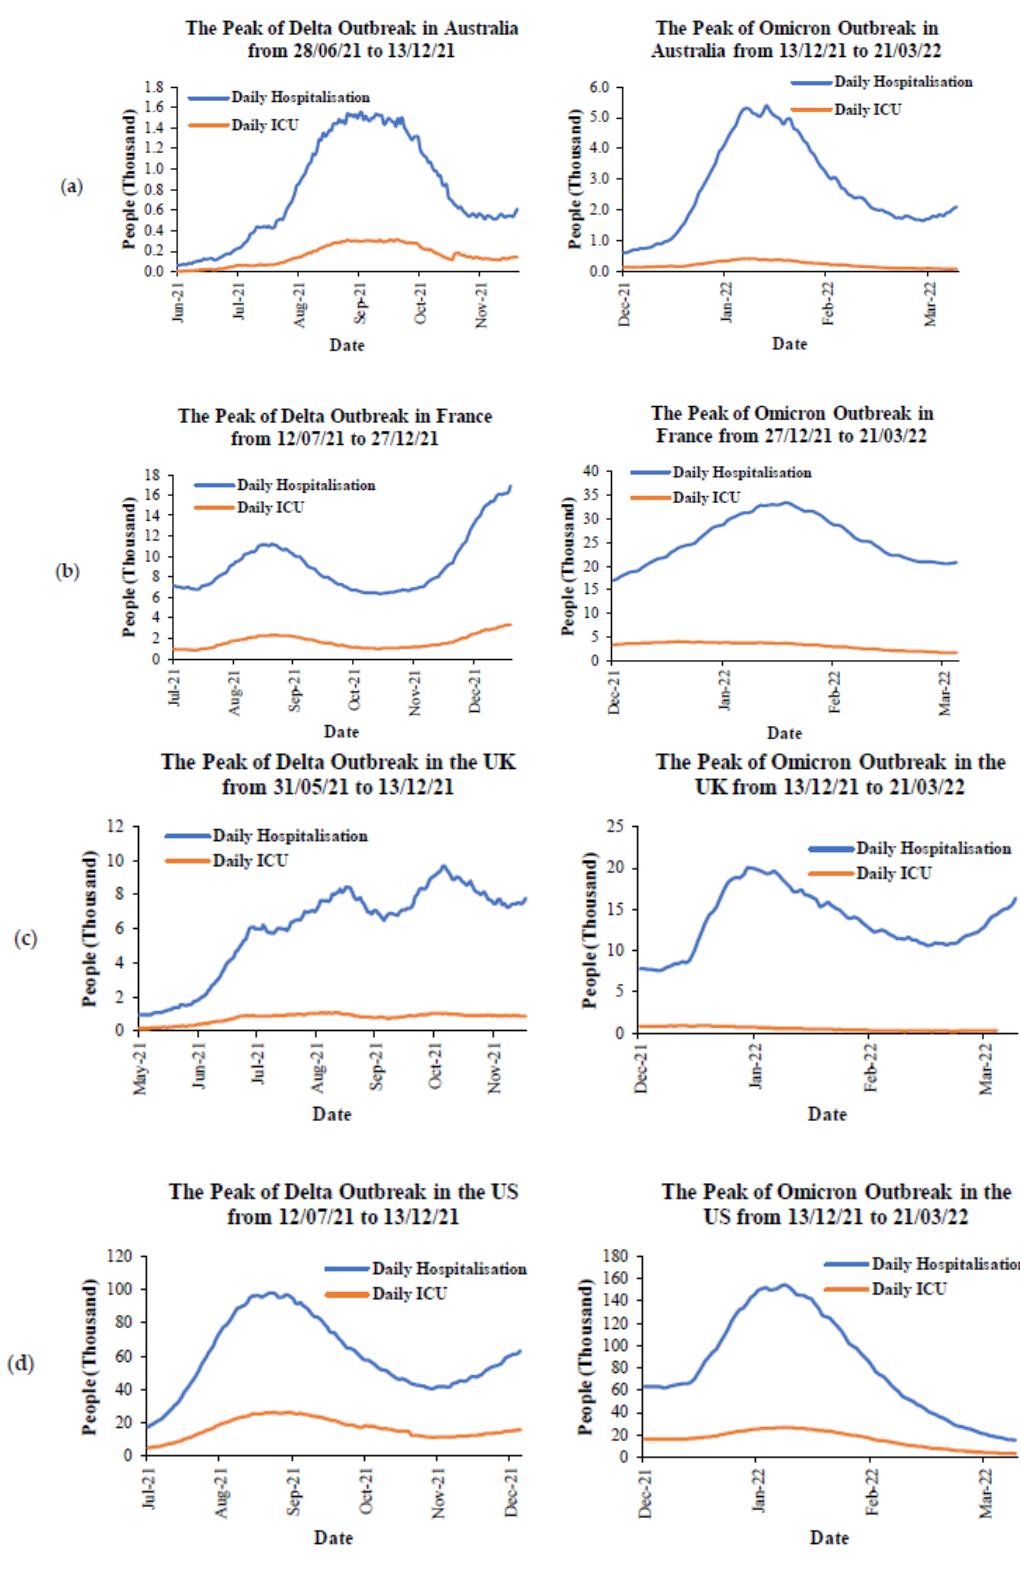
Figure 13. The comparison of severity during the peaks of Delta and Omicron outbreaks in: ( a ) Australia, ( b ) France, ( c ) the UK, and ( d ) the US.